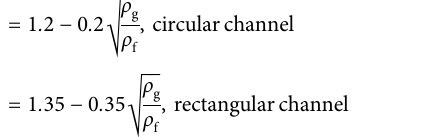
Compared with medium size channels, the different fl ow phenomena observed in large size channels are the formation of liquid recirculation (secondary fl ow) patterns in a bubbly fl ow and the disintegration of large bubbles due to surface instabilities (Abbs and Hibiki, 2019). Kataoka and Ishiii (1987) took the secondary fl ow in gas-water two-phase fl ow under the stagnant liquid conditions into account and developed the